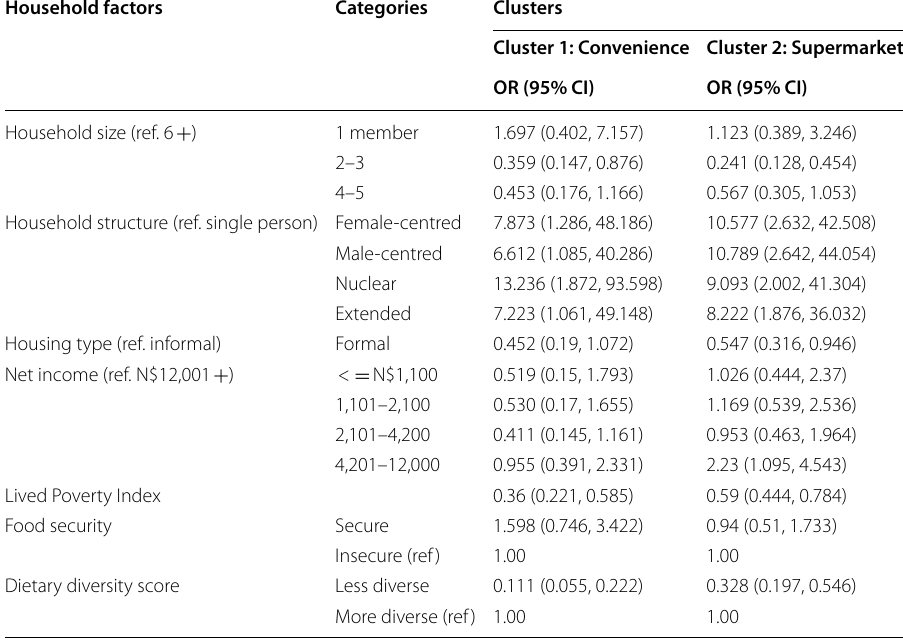
Table 7 Multiple logistic regression of food source clusters Household